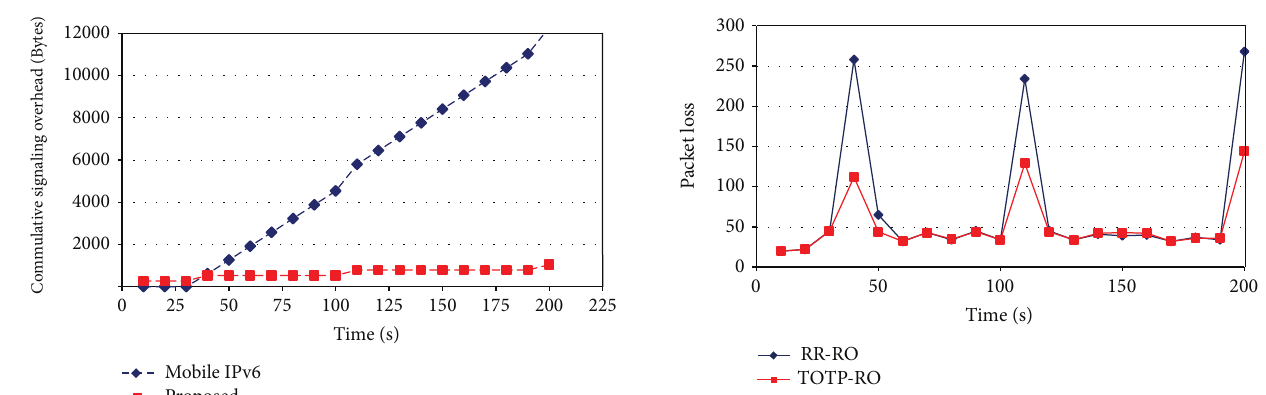
Figure 8: Signalling overhead comparison.